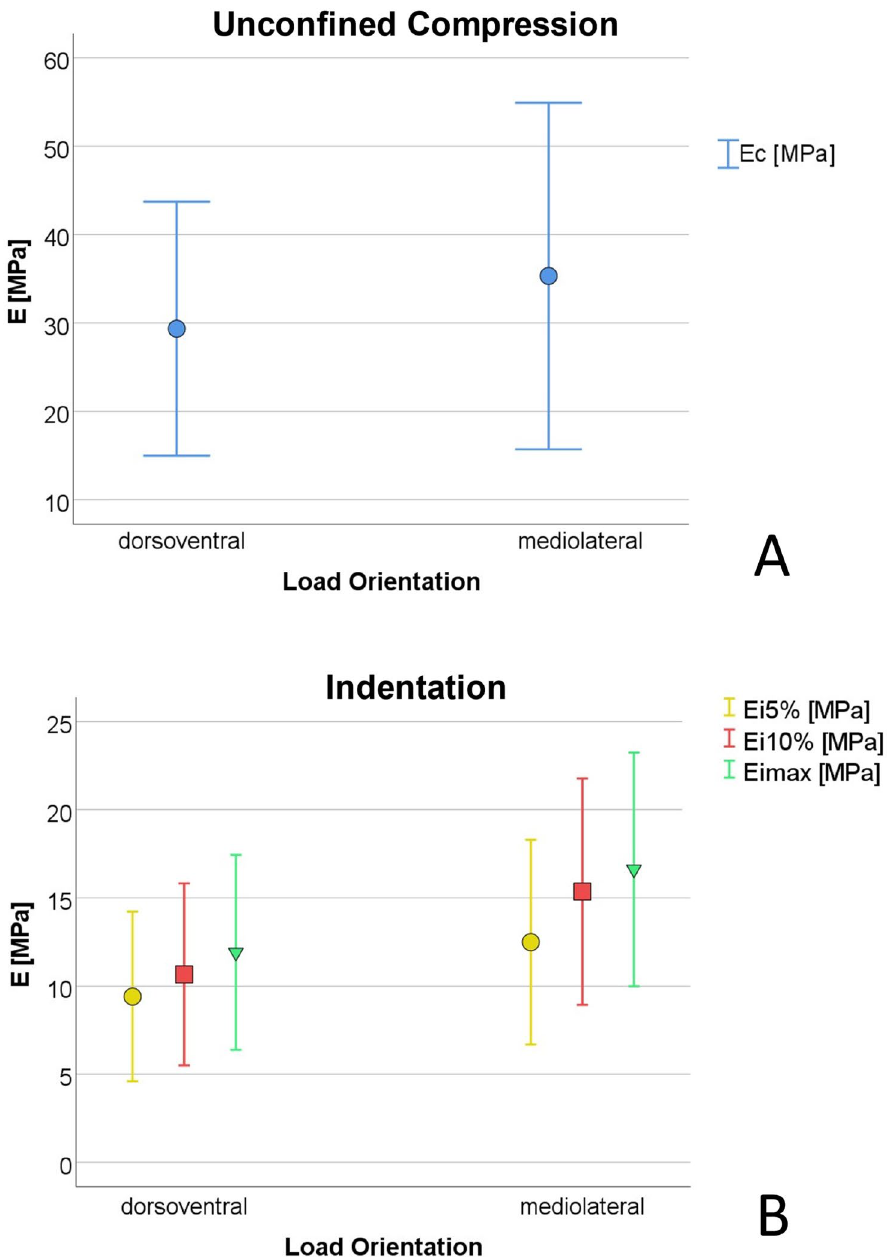
Figure 5. The effect of the load orientation on the Mean Young’s Moduli for ( A ) the unconfined compression